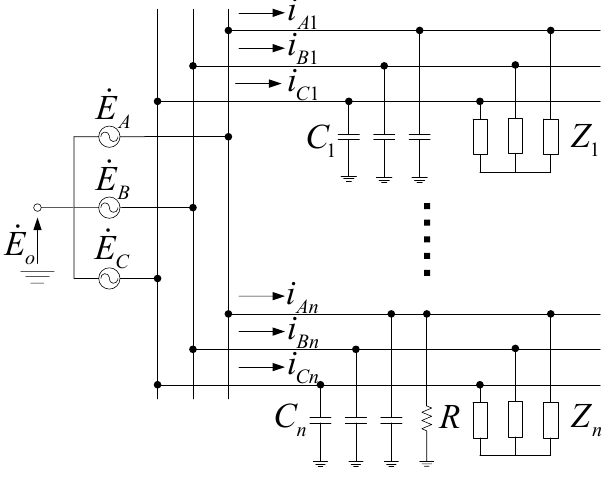
Figure 13. Equivalent circuit of single phase-to-ground of isolated neutral